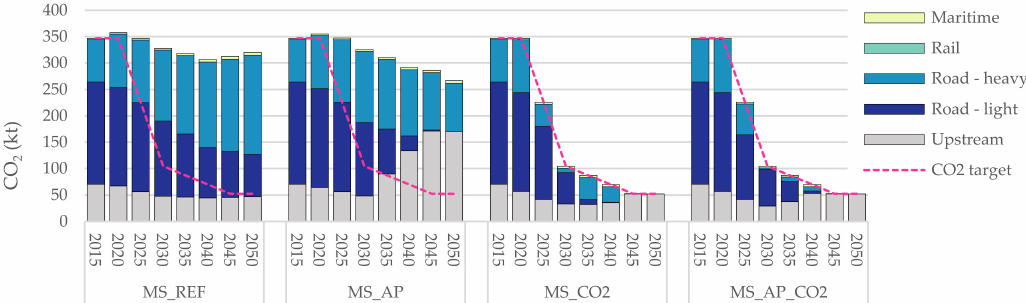
Figure A6. Total upstream and by-mode tailpipe emissions of carbon dioxide (CO 2 ) in the mode shift (MS) scenarios (kt). Note : Road—heavy = buses, MGVs and HGVs; Road—light = cars and LCVs.